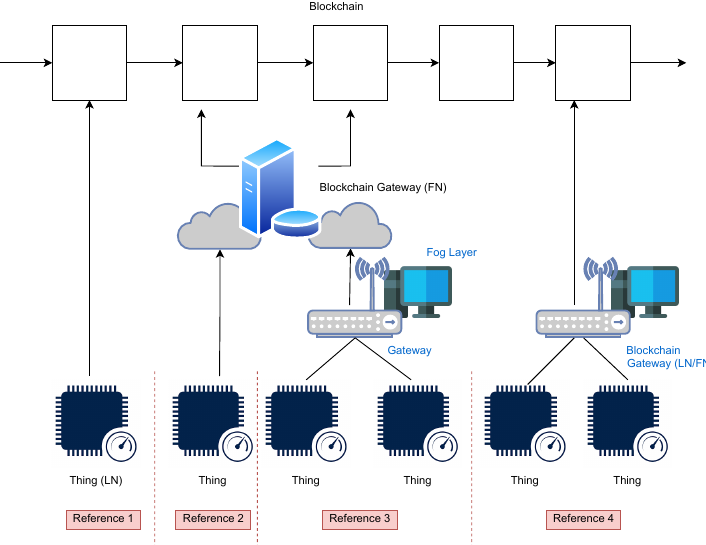
Figure 4. There are four main types of reference scenarios. In Reference 1, things have sufficient resources to operate autonomously as light nodes (LN). In Reference 2, things can autonomously be connected to the Internet, but their limited resources require them to rely upon third-party blockchain services to interact with the blockchain. In Reference 3, things need to rely on a gateway to access the Internet, but also in this case, the gateway or a server of a fog computing layer does not have sufficient resources to interact with the blockchain, and thus it relays on a third party. In Reference 4, things still need a gateway or an intermediate fog computing layer, but in this case, the gateway or the server has sufficient resources to run a light (LN) or full (FN) blockchain